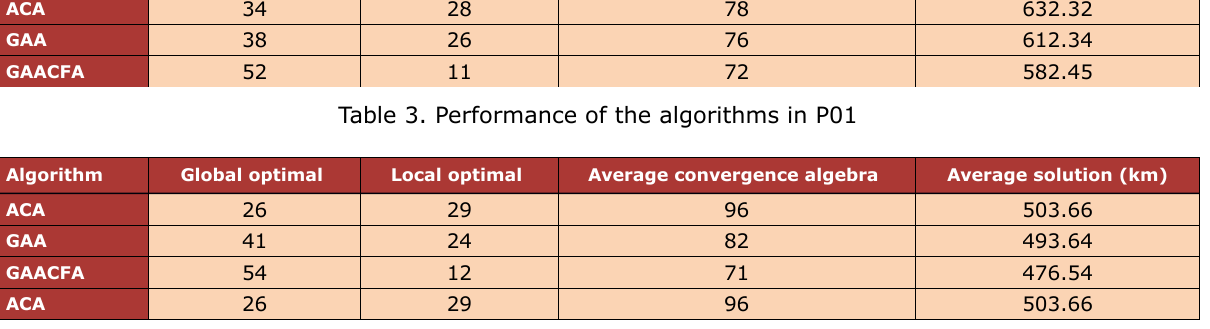
Table 4. Performance of the algorithms in